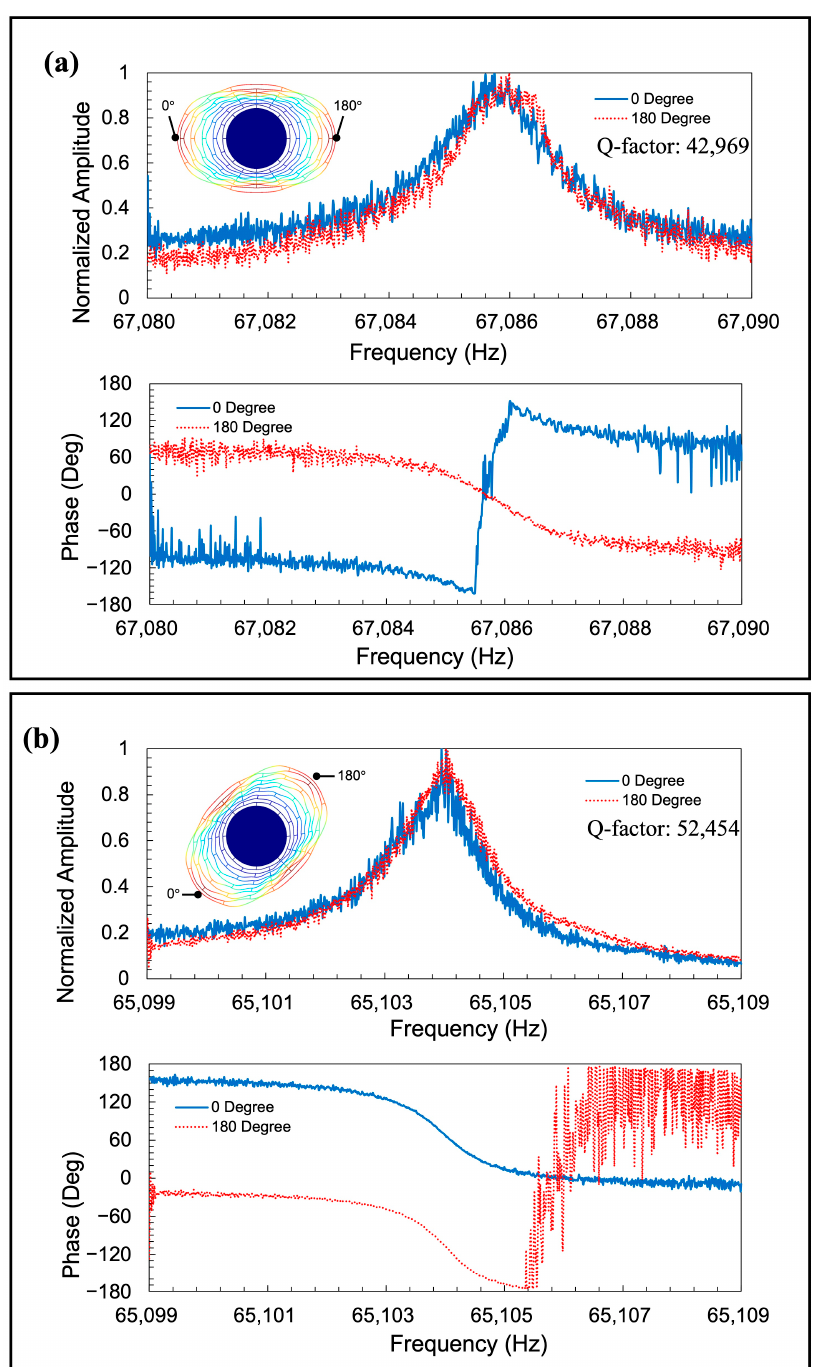
Figure 14. Detected amplitude change and phase change from actuated resonator with linear beams in ( a ) Mode 1 and ( b ) Mode 2.